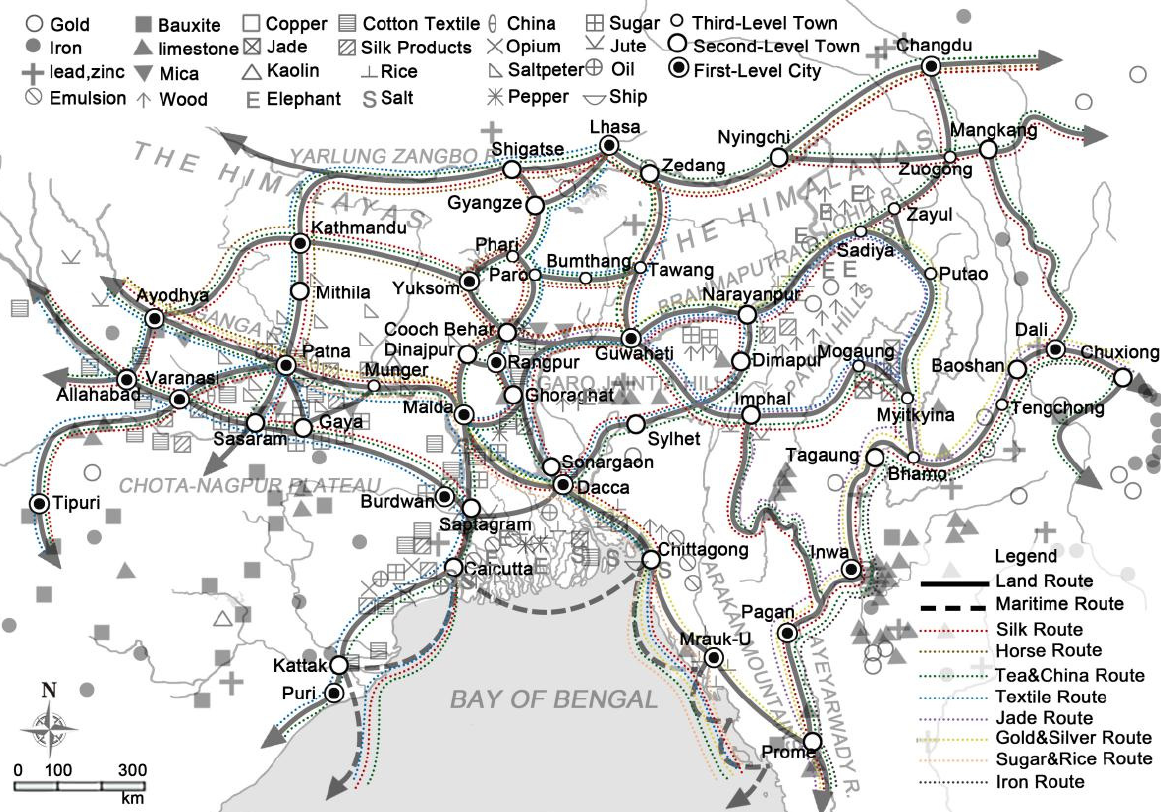
Figure 8. Distribution of resources and products in the middle and lower Ganges Valley and the inferred trade routes in Myanmar, China’s Tibet and Yunnan from the 16th to the Mid-18th Century. Source: the authors; Reference: [36].